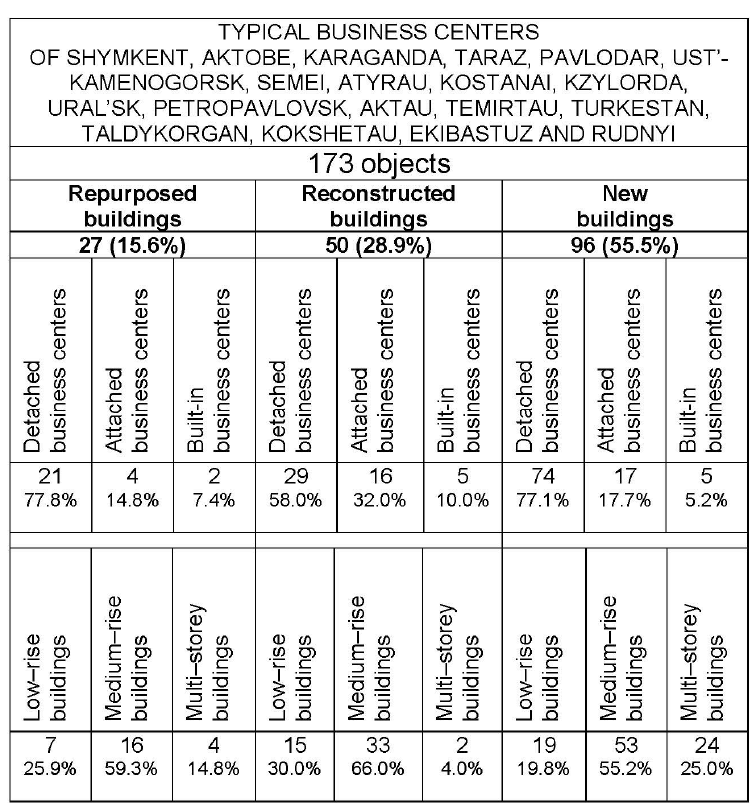
Figure 26. The differentiation of typical business centers of Shymkent, Aktobe, Karaganda, Taraz, Pavlodar, Ust’-Kamenogorsk, Semey, Atyrau, Kostanay, Kyzylorda, Ural’sk, Petropavlovsk, Aktau, Temirtau, Turkestan, Taldykorgan, Kokshetau, Ekibastuz, and Rudnyi.